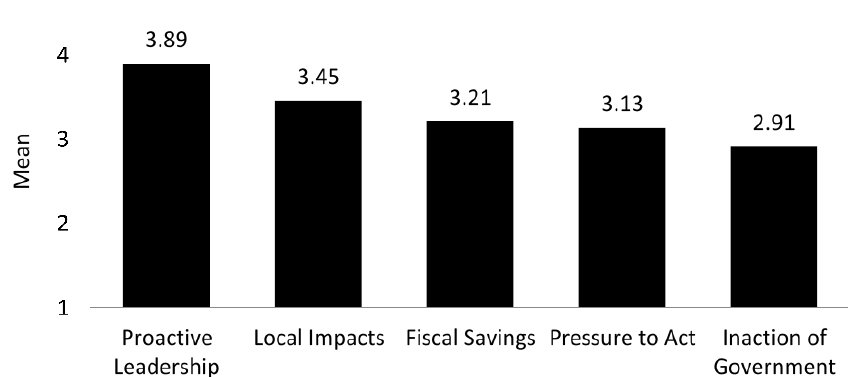
Figure 2. Mean scores for factors influencing natural resource professionals actions regarding climate adaptation and mitigation actions where 1 = not at all important, 2 = slightly important, 3 = somewhat important, 4 = important, 5 = very important.